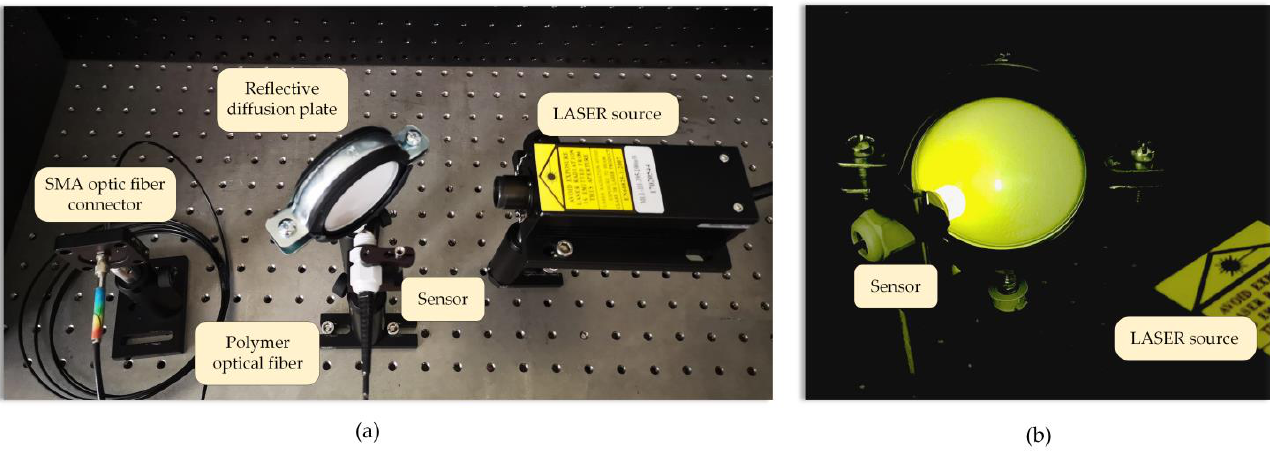
Figure 5. General view of the laboratory test stand ( a ) and experiment in which the illumination of the sensor head under UV laser excitation is shown ( b ).